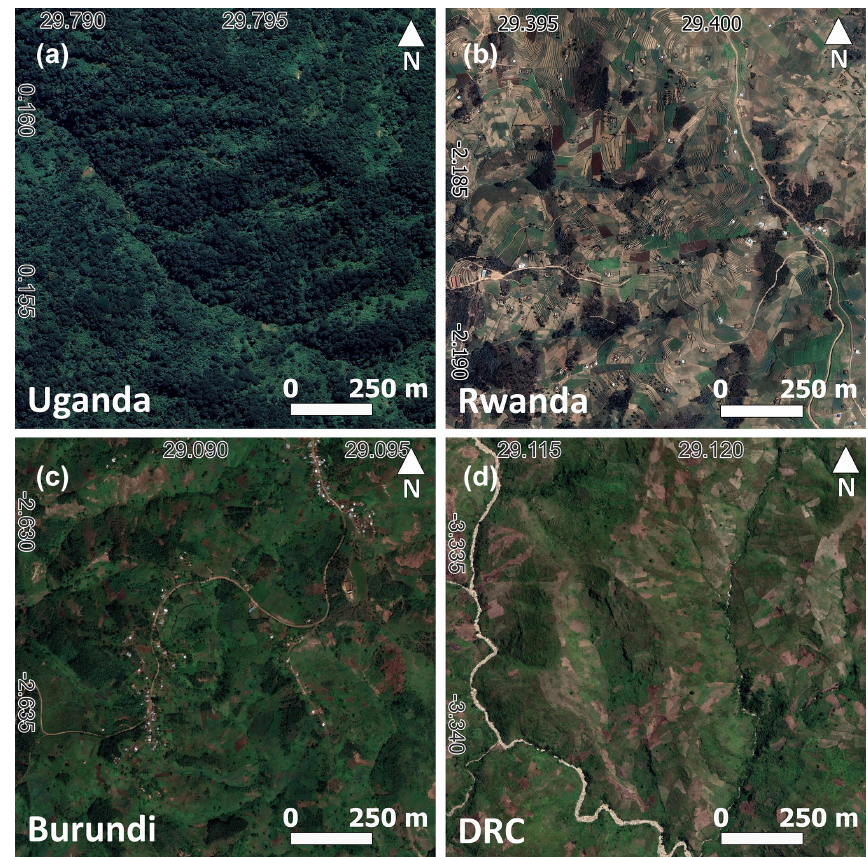
Figure 2. Closeup of the contrasting typical landscapes of the four GH events. Maps data: Google, © 2022 CNES/Airbus (a, b) , Google, © 2022 Maxar Technologies (c, d)